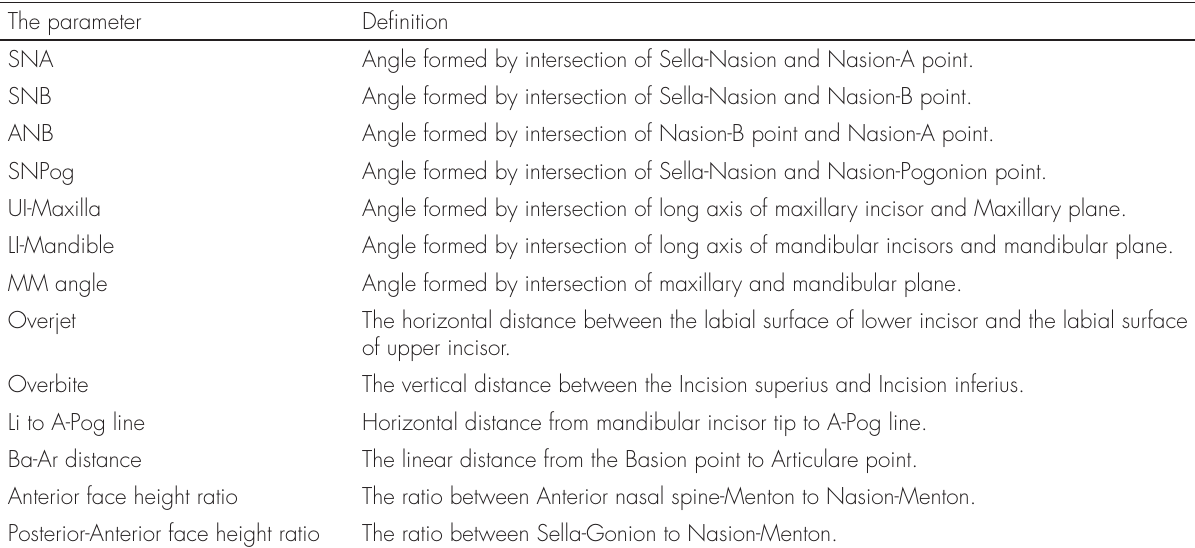
Table IV. Definitions of cephalometric parameters.